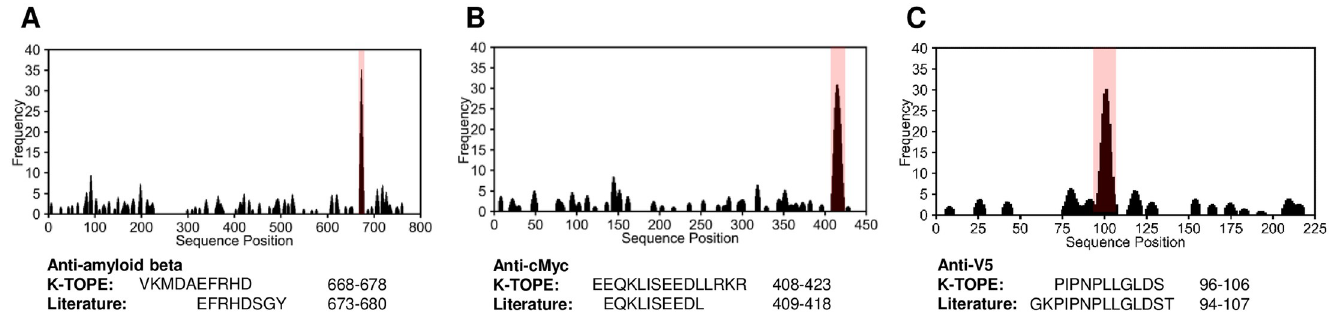
Fig 2. K-TOPE found epitopes for antibodies with known specificity spiked into serum. Histograms for antibodies with known specificity against amyloid beta (P05067), cMyc (P01106), and V5 (P11207) had prominent epitopes with epitope percentiles > 99.9% (in pink). (A) K-TOPE analysis of amyloid beta determined the epitope VKMDAEFRHD (668–678). This antibody was raised to whole protein and is known from literature to have a conformation-specific discontinuous epitope that maps to segments EFRHDSGY (673–680) and ED (692–693). (B) K-TOPE analysis of cMyc determined the epitope EEQKLISEEDLLRKR (408–422). This antibody was raised to AEEQKLISEEDLLRKRRE (407–424). (C) K-TOPE analysis of V5 determined the epitope PIPNPLLGLDS (96–106). The antibody was raised to GKPIPNPLLGLDST (94–107).